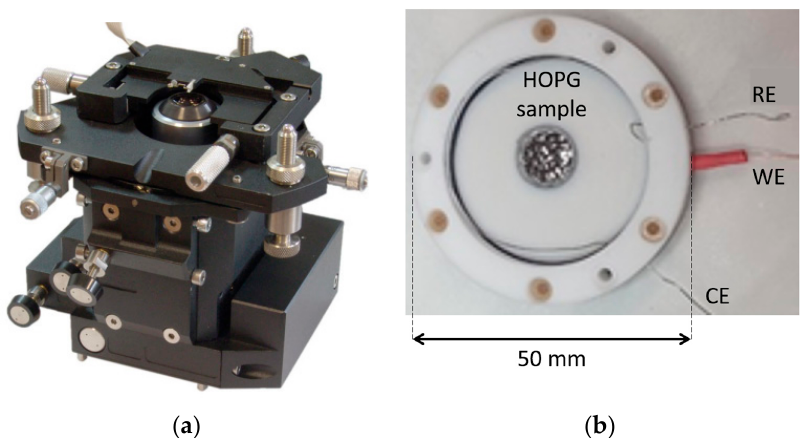
Figure 2. ( a ) An upside-down image (for a better view) of the mechanical system used for the laser beam positioning close to the AFM tip. ( b )The EC-cell employed with the NTEGRA system. Electrodes (denoted as RE, WE and CE) and the HOPG sample are clearly visible in the photo.